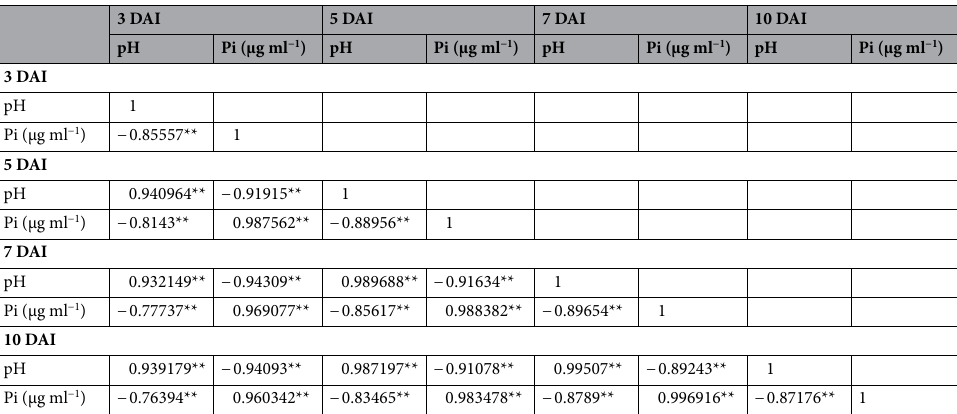
Table 8. Correlation data between pH change and Pi release in isolates broth. **Means significant at P = 0.05 and